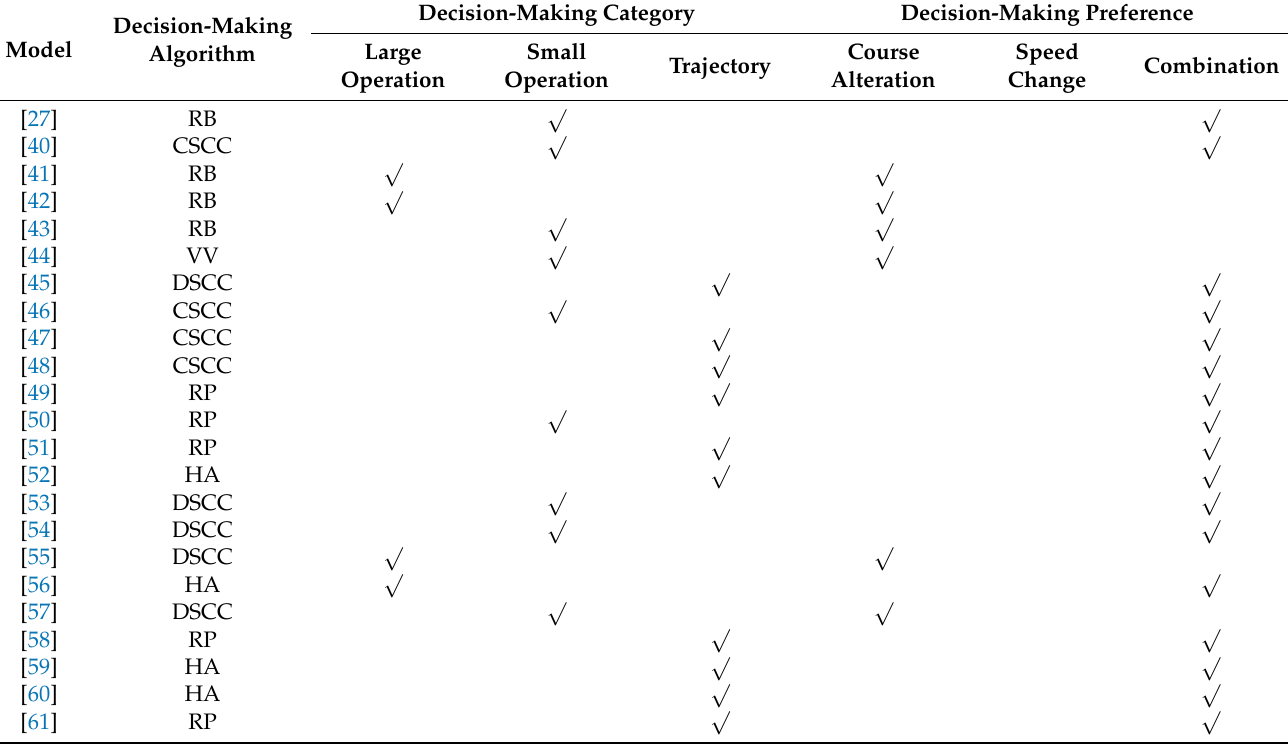
Table 6. Overview of the behavioral characteristics of the intelligent decision-making process in the models in the